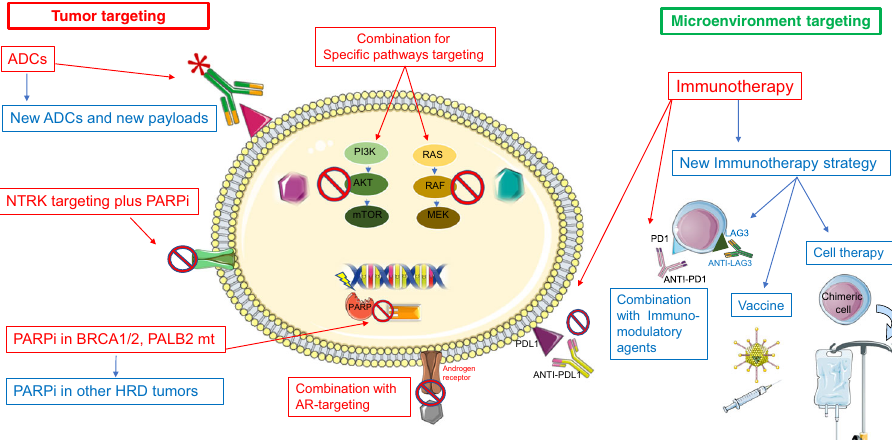
Fig. 5 Therapeutic approaches in metastatic TNBC (red: current approaches, Blue: future directions). ADC antibody drug conjugate; PARPi: poly-ADP ribose polymerase inhibitors; HRD homologous recombination de fi ciency; AR androgen receptors. Figure includes modi fi ed templates from Servier Medical Art